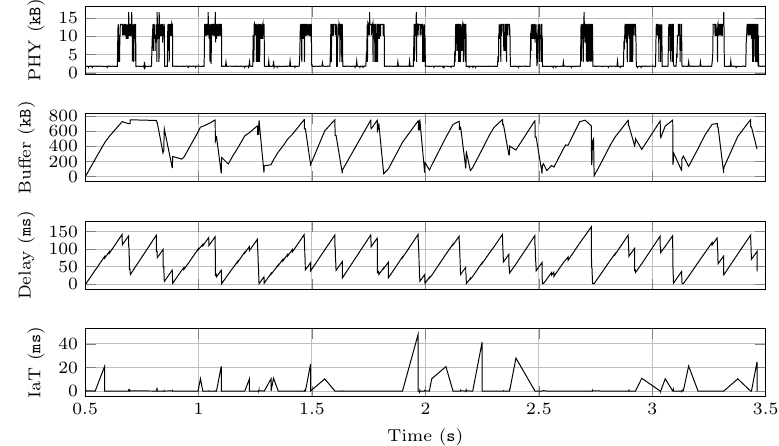
Figure 2. System parameters with distance and traffic rate of 30 m and 50 Mbps, respectively, using the greedy scheduler.